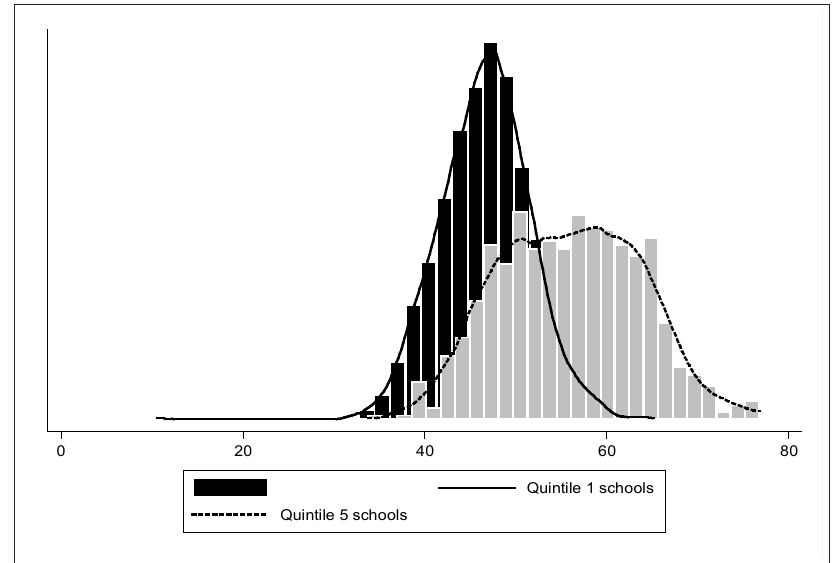
Figure 6: Distribution of 2013 NSC examination by average school aggregate mark (Source: Author’s calculations, based on NSC and EMIS data) Data integration is also necessary to create a longitudinal data set.